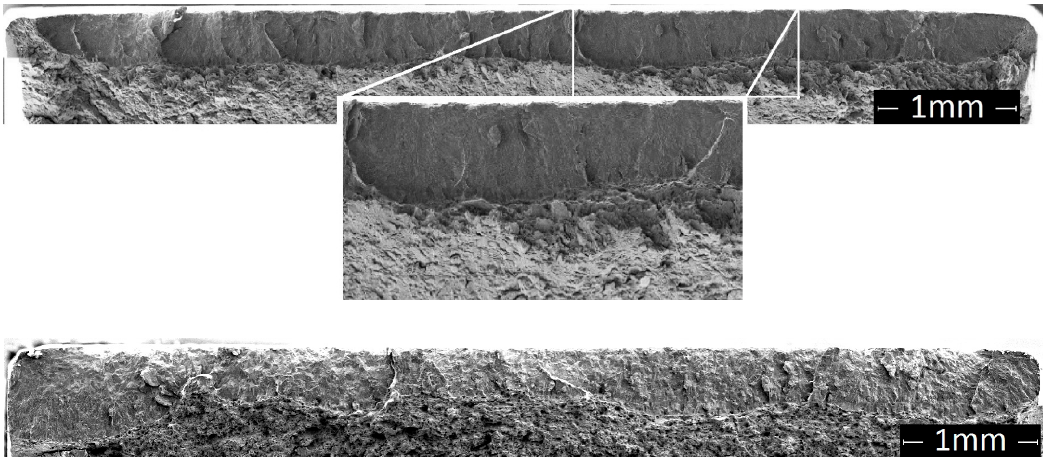
Figure 10. Fracture surfaces on both sides of a specimen with Load Combination 2, without shot peening and interrupted at 93,740 cycles.